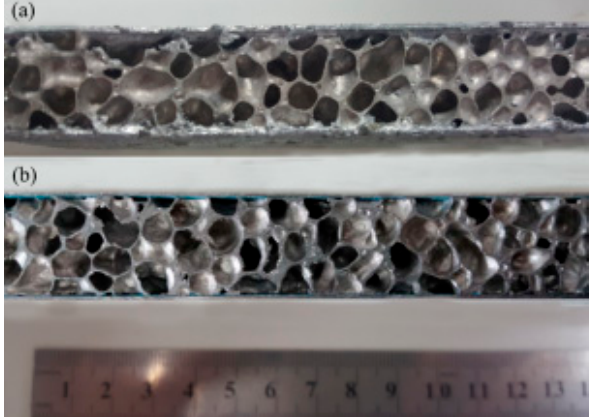
Figure 1. Two kinds of AFS (Aluminum Foam Sandwich) panels from different manufacturing process ( a ) metallurgical joining ( b ) adhesive joining.